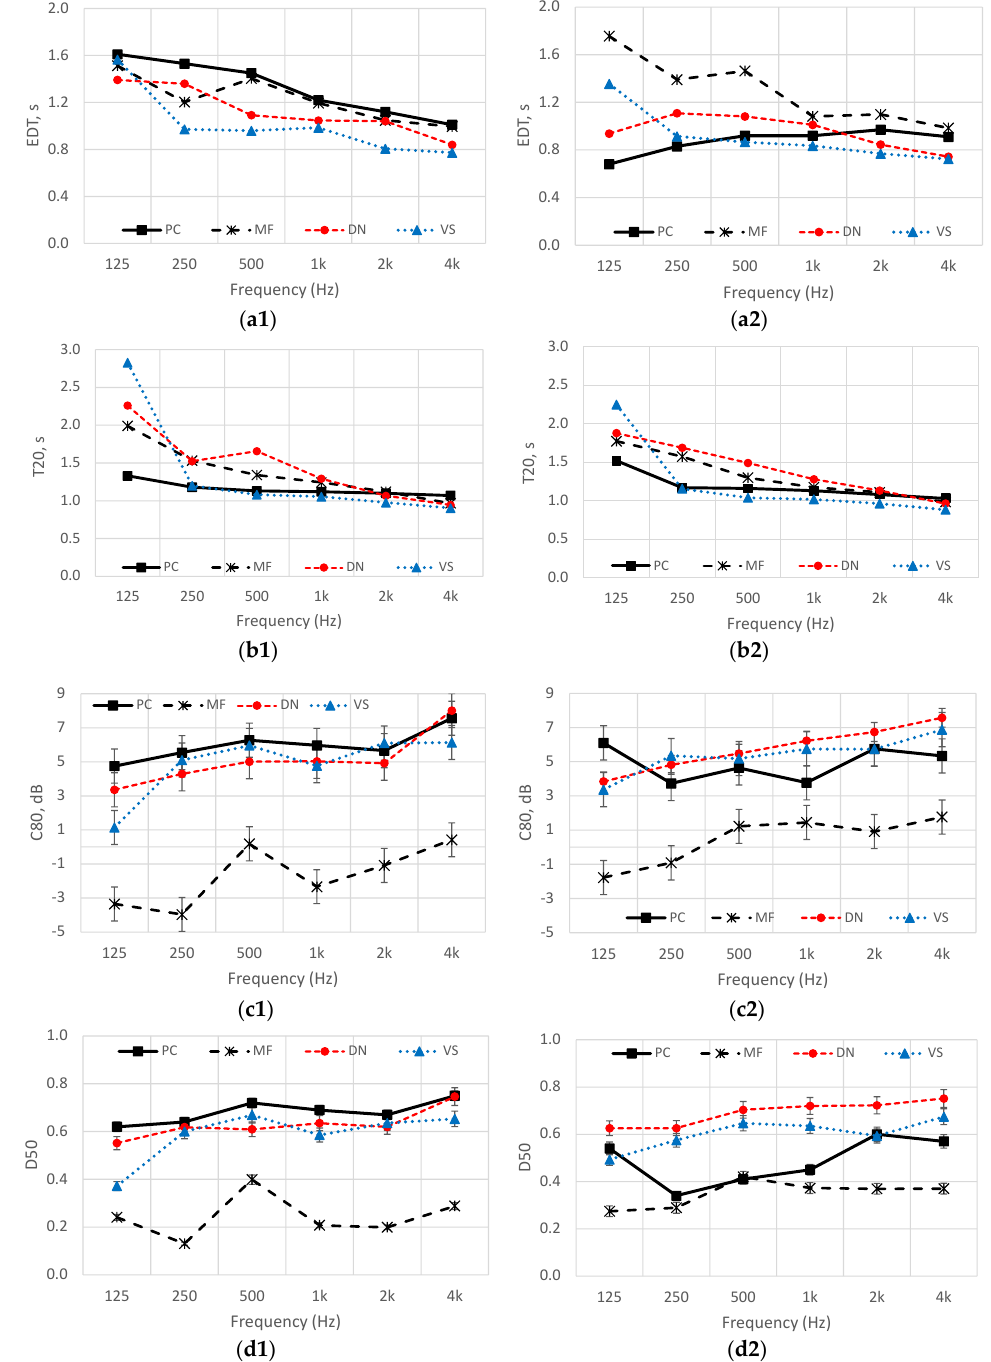
Figure 13. Comparison of measured results with other Italian Opera theaters: EDT ( a1 , b1 ), T 20 ( b1 , b2 ) C 80 ( c1 , c2 ) and D 50 ( d1 , d2 ). Type 1 stands for results measured in the stalls. Type 2 stands for results measured in boxes.